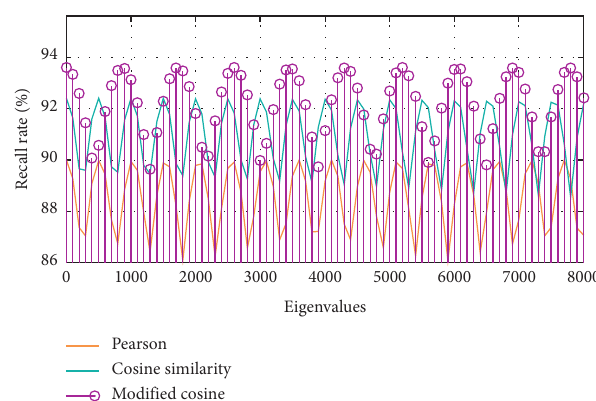
Figure 8: Comparison of recall rates of different similarity cal- culation functions.